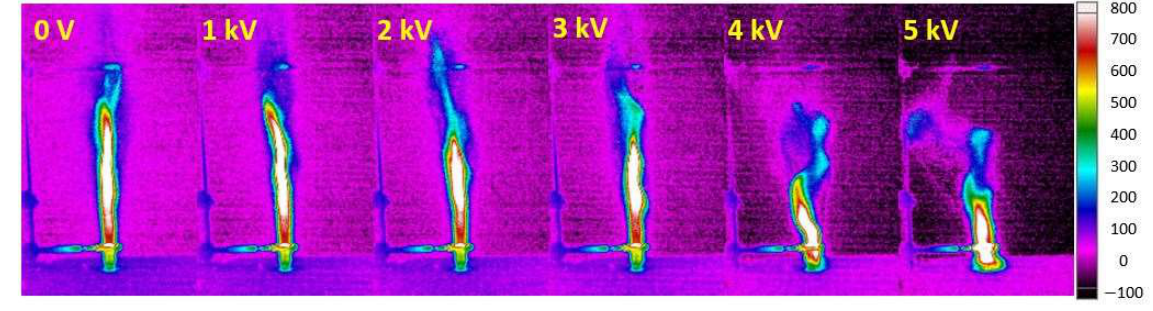
Figure 5. Infrared image for positive polarity (°C): ( a ) stoichiometry case; ( b ) fuel-rich case; ( c ) fuel-lean case.